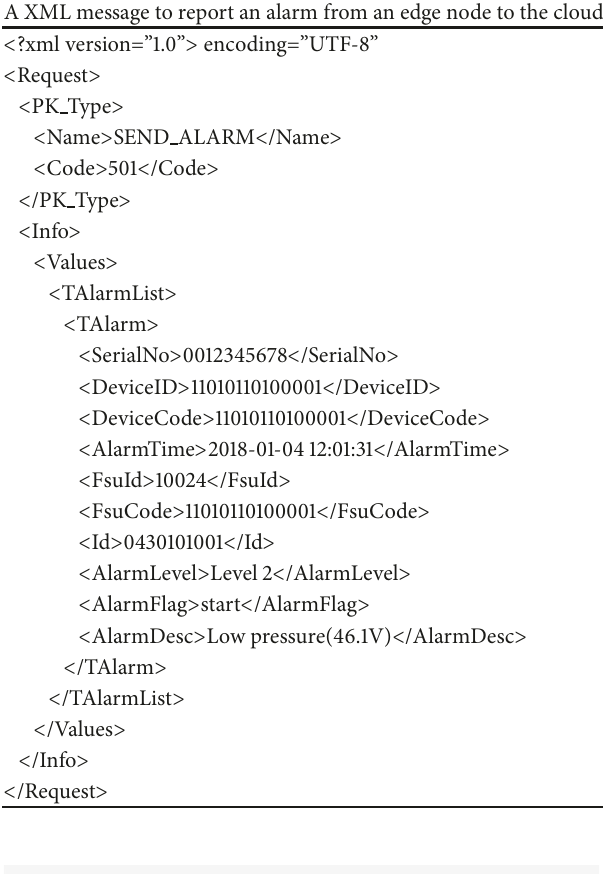
Table 2: An example of a data request by an edge node.